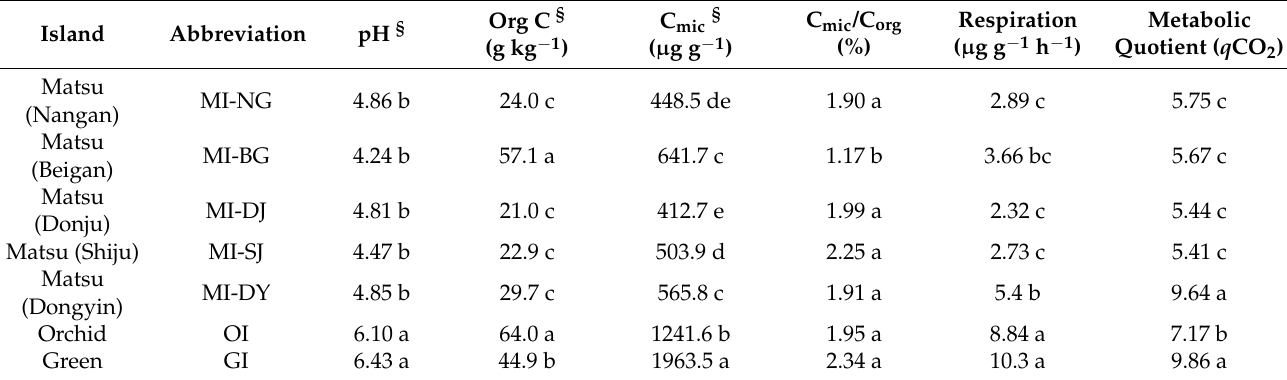
Table 1. Soil microbial biomass and activity characteristics of different